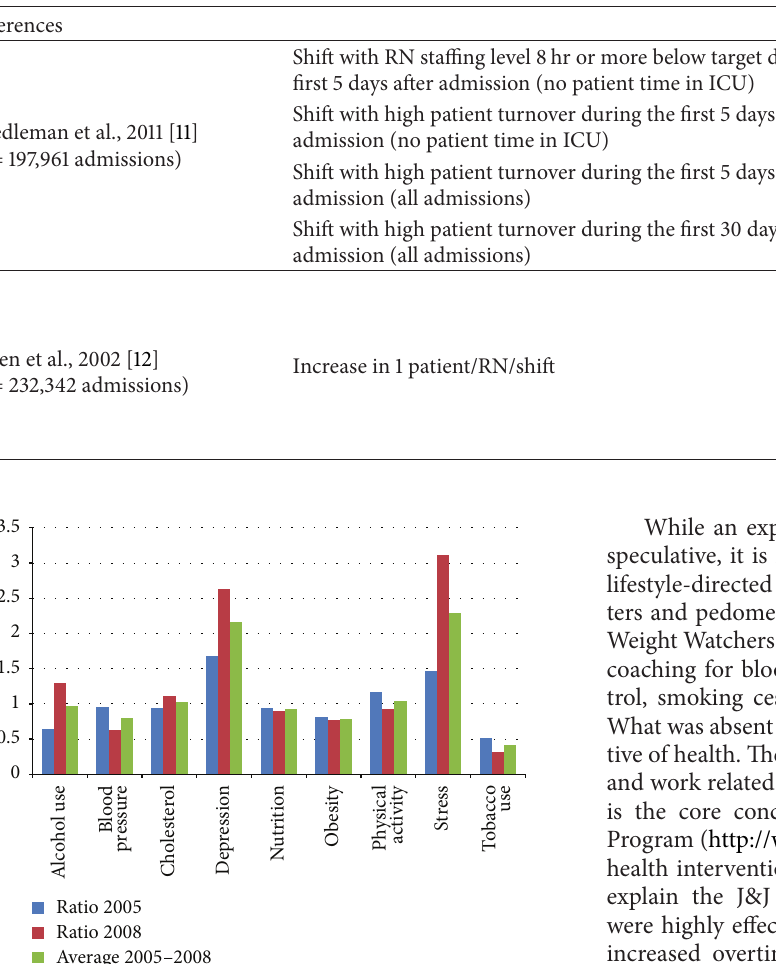
Table 1: Consequences of nursing understaffing.